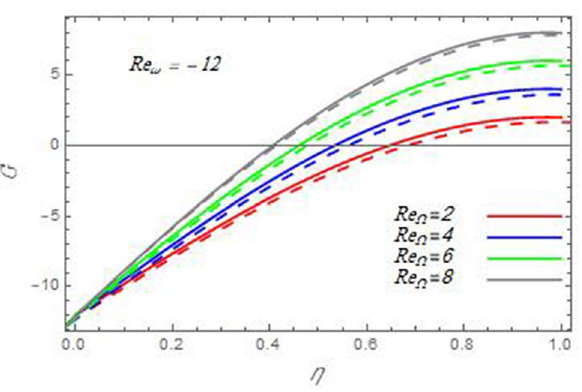
Figure 14. A comparison of the azimuthal velocity G between the current study and Ref. 58 in the case Re ω 12 with the same values of the Reynolds number Re (cid:31) . = −